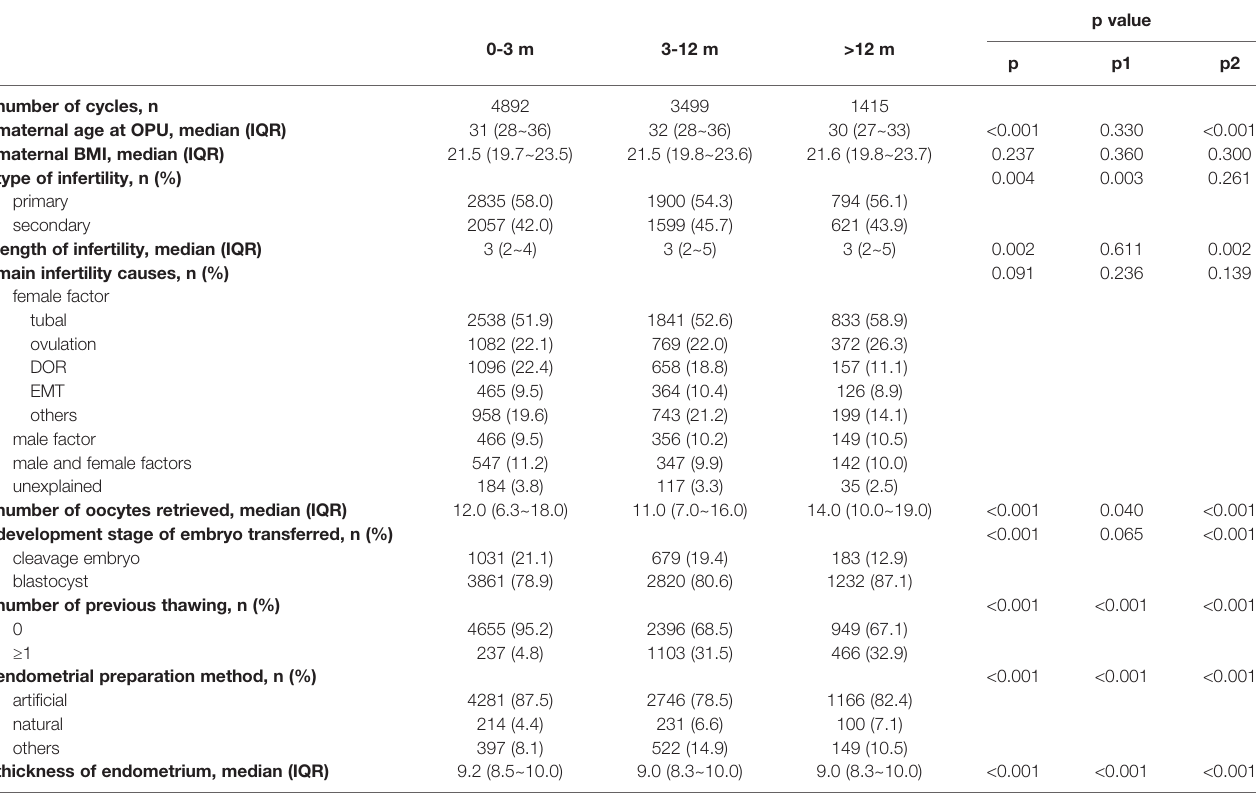
TABLE 1 | Baseline characteristics of single vitri fi ed embryo transfer